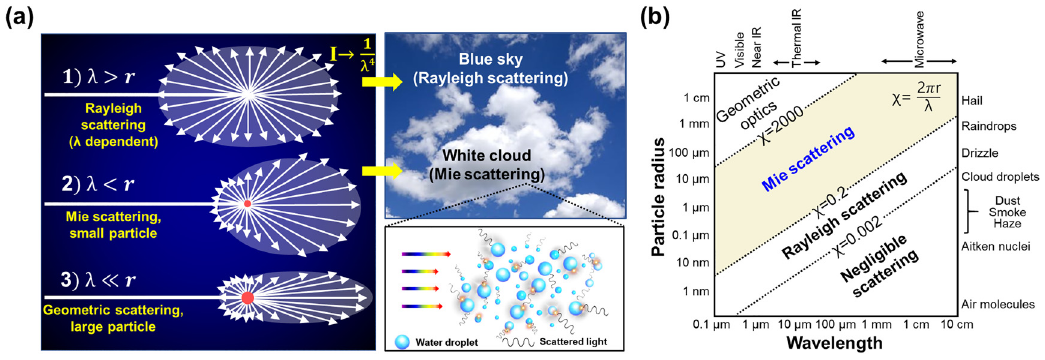
Figure 2: Dynamically tunable light scattering. (a) Light scattering dependence on the size of the scattering particle and associated examples. (b) Scattering regime dependence on the wavelength of the incident radiation and the particle radius of the